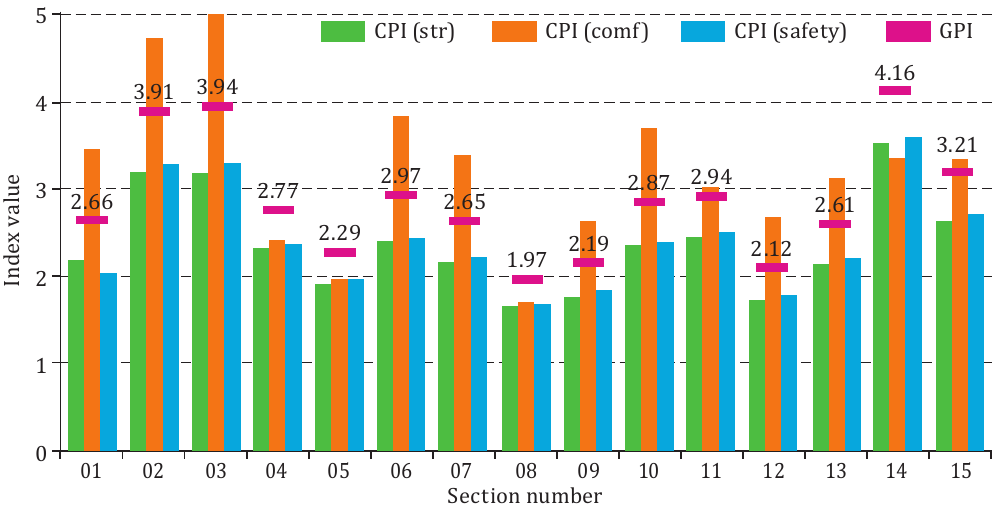
Figure 3. Comparison of the combined performance indicators (structural, comfort and safety) as well as global performance indicator (based on the methodology by COST